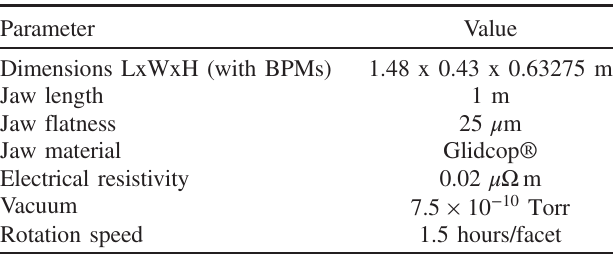
TABLE I. Summary of key design specifications of the rotat- able collimator